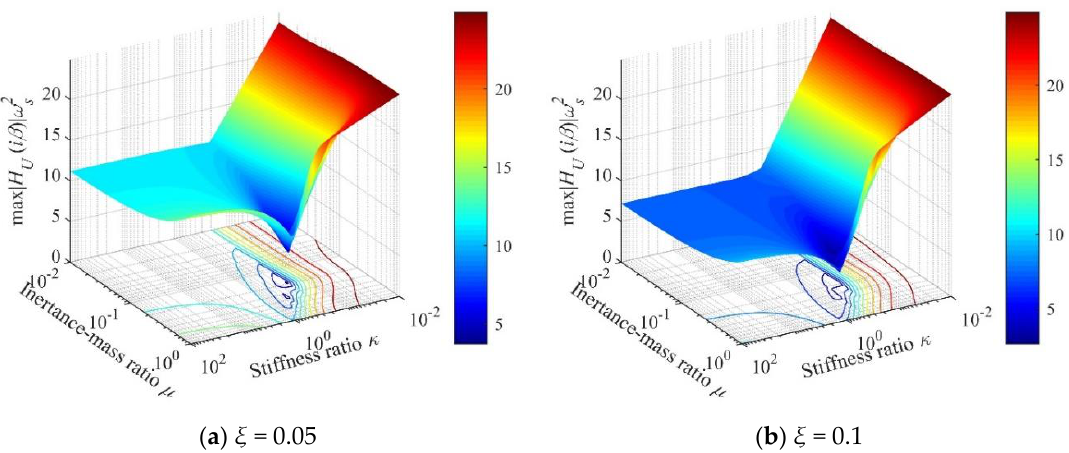
Figure 6. Displacement amplification factor of a CBIS-equipped SDOF structure with changes in κ ∈ [ 0.01,100 ] and µ ∈ [ 0.01,1 ]